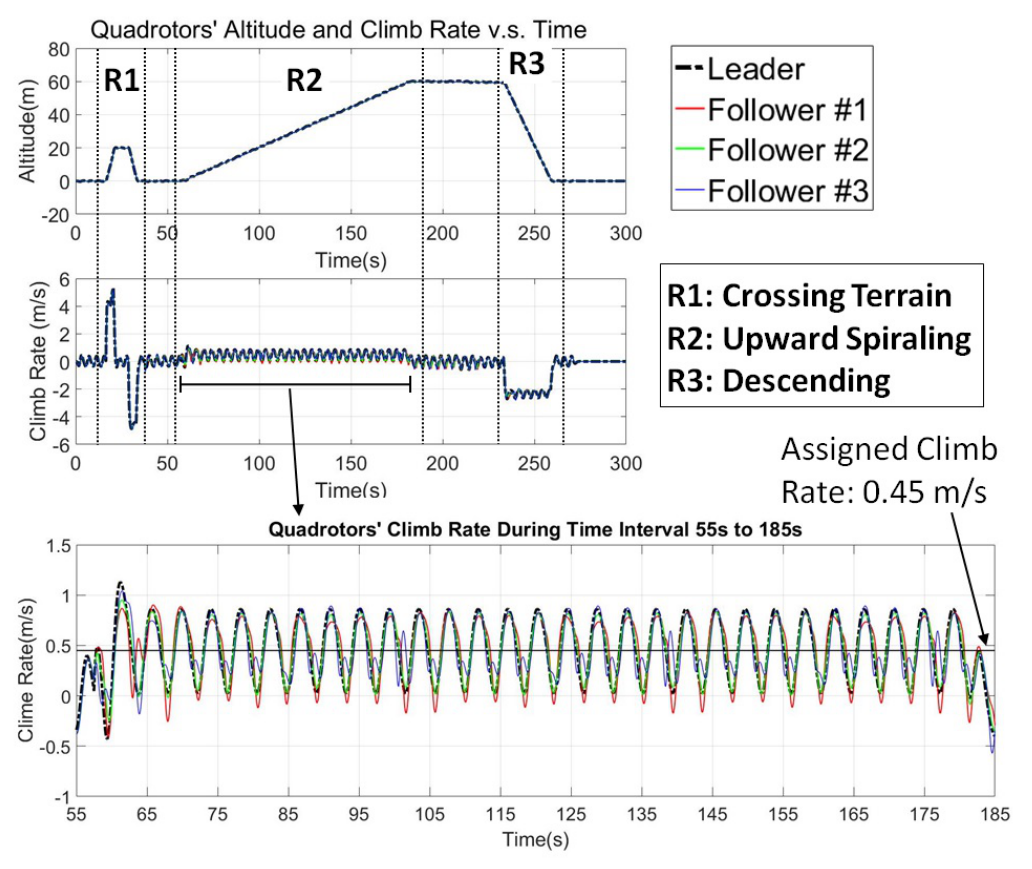
Figure 15. Quadrotor altitude and climb rate throughout the comprehensive